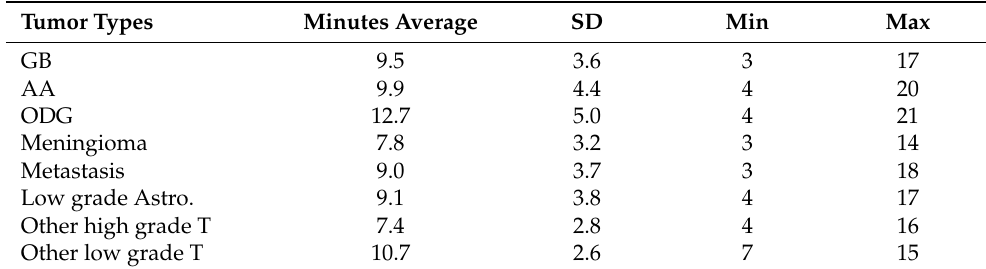
Table 4. Summary of the evaluation times for each tumor type.